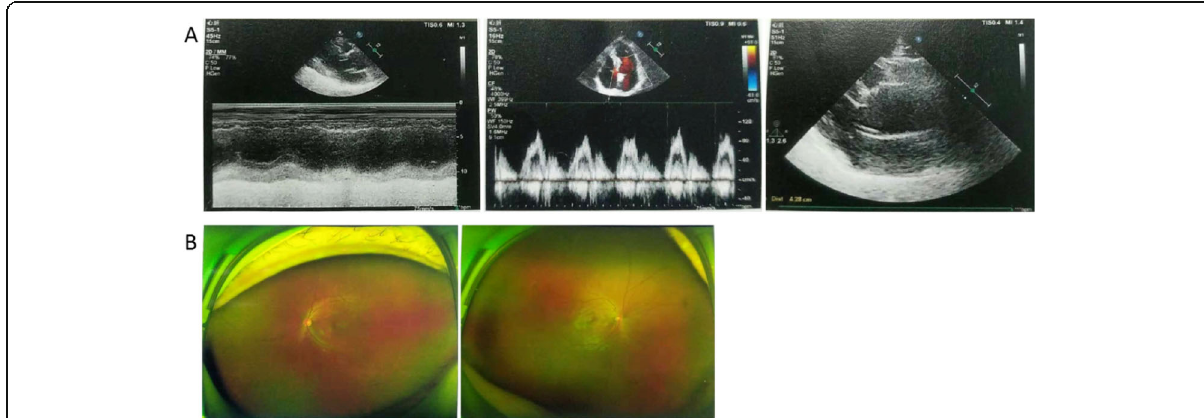
Fig. 2 Clinical diagnosis of the proband. 2A: Ultrasonic cardiogram; 2B: Ocular ultrasound. Echocardiography showed dilatation of ascending aorta and main pulmonary artery, mitral regurgitation (mild), tricuspid regurgitation (mild), and abnormal left ventricular filling ( a ). Ocular ultrasound showed vitreous opacity ( b )